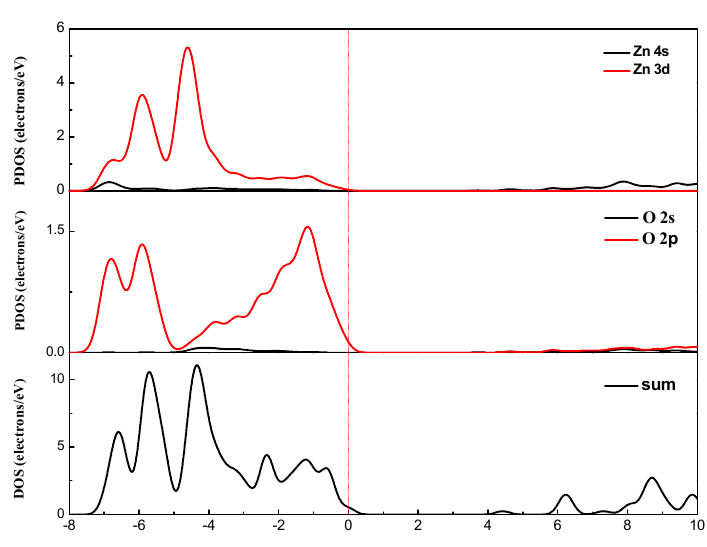
Figure 4. Partial density of states (PDOS) for pure ZnO.